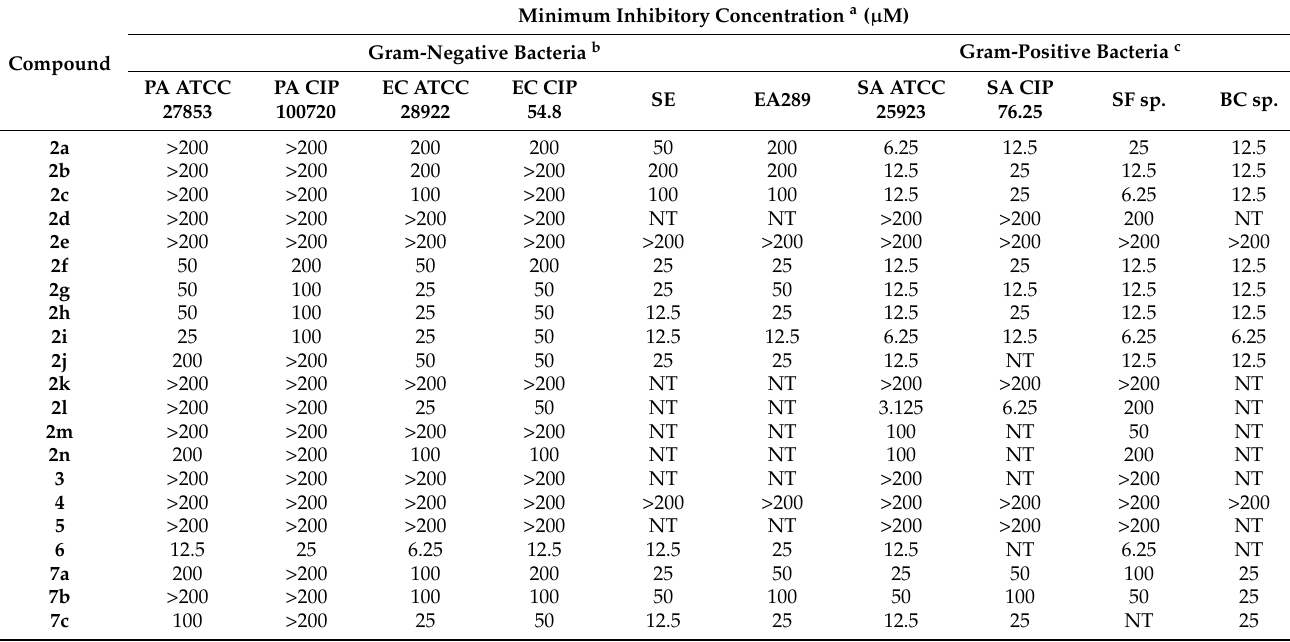
Table 1. Antimicrobial activities of oleanolic acid derivatives 2a – n , 3 – 6 , 7a – c .